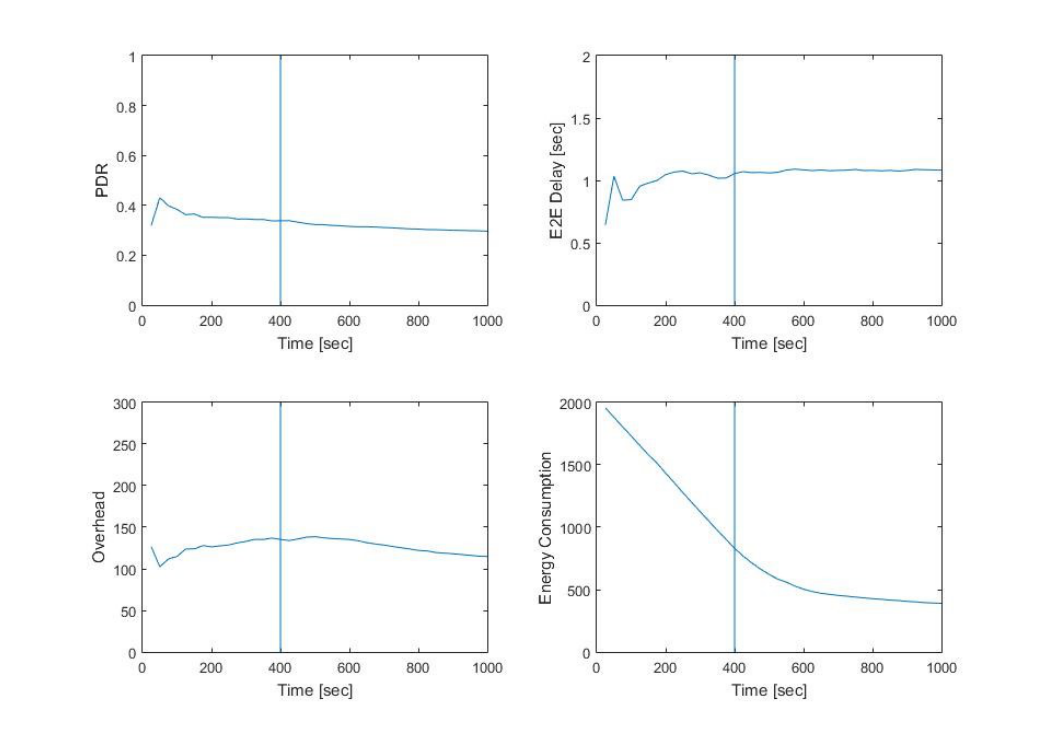
Fig. 6. Evaluation of OLSR protocol based on 40 mobile sensor nodes